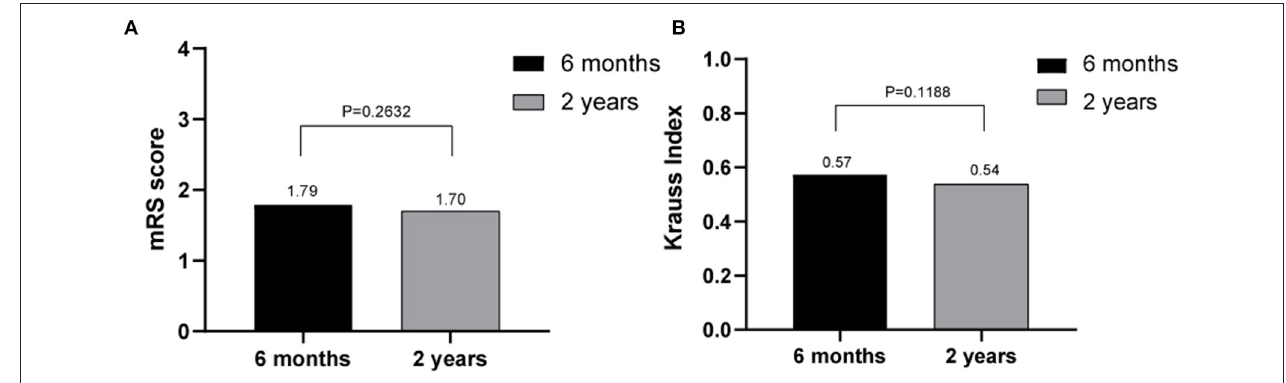
FIGURE 2 | Comparison of the effects of shunt surgery at 6 months and 2 years using Krauss index scores (A) and modified Rankin scale scores (B) ; no statistically significant differences were observed ( p > 0.05).